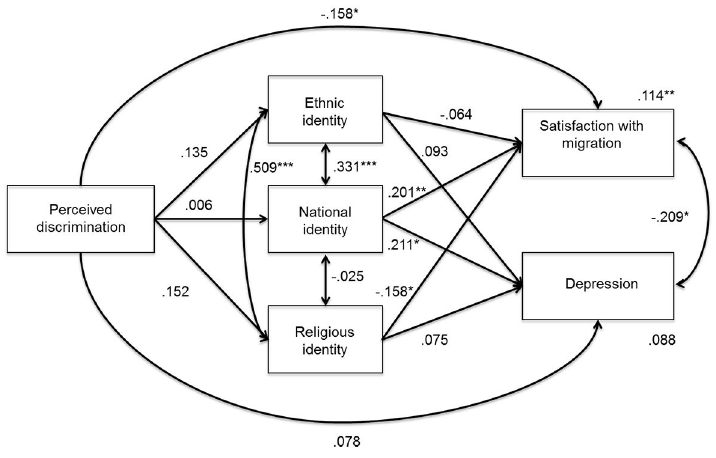
Figure 2. Multigroup mediational model: First generation Muslims.